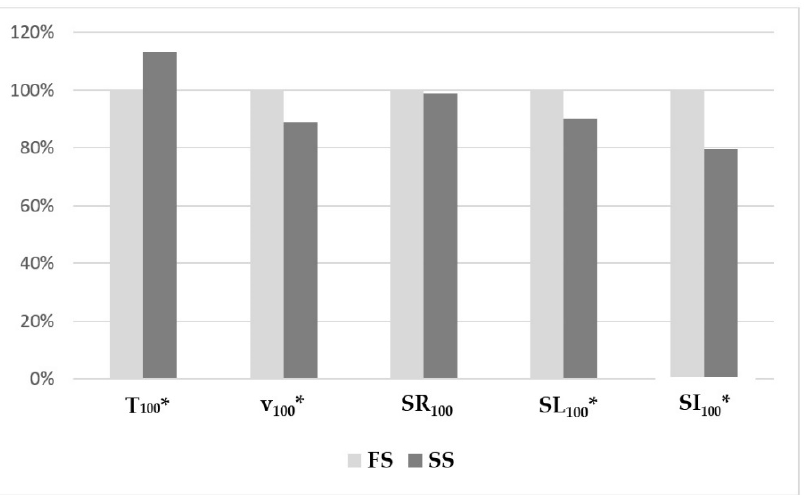
Figure 2. Values of indices in FS (faster swimmers) and SS (slower swimmers) groups for the 100 m freestyle race in percentages (the value for the FS group was assumed as 100%). T 100 —time of 100 m race, v 100 —mean velocity, SR 100 —mean stroke rate, SL 100 —mean stroke length, SI 100 —mean stroke index. *—difference between the FS and SS groups at p < 0.05.